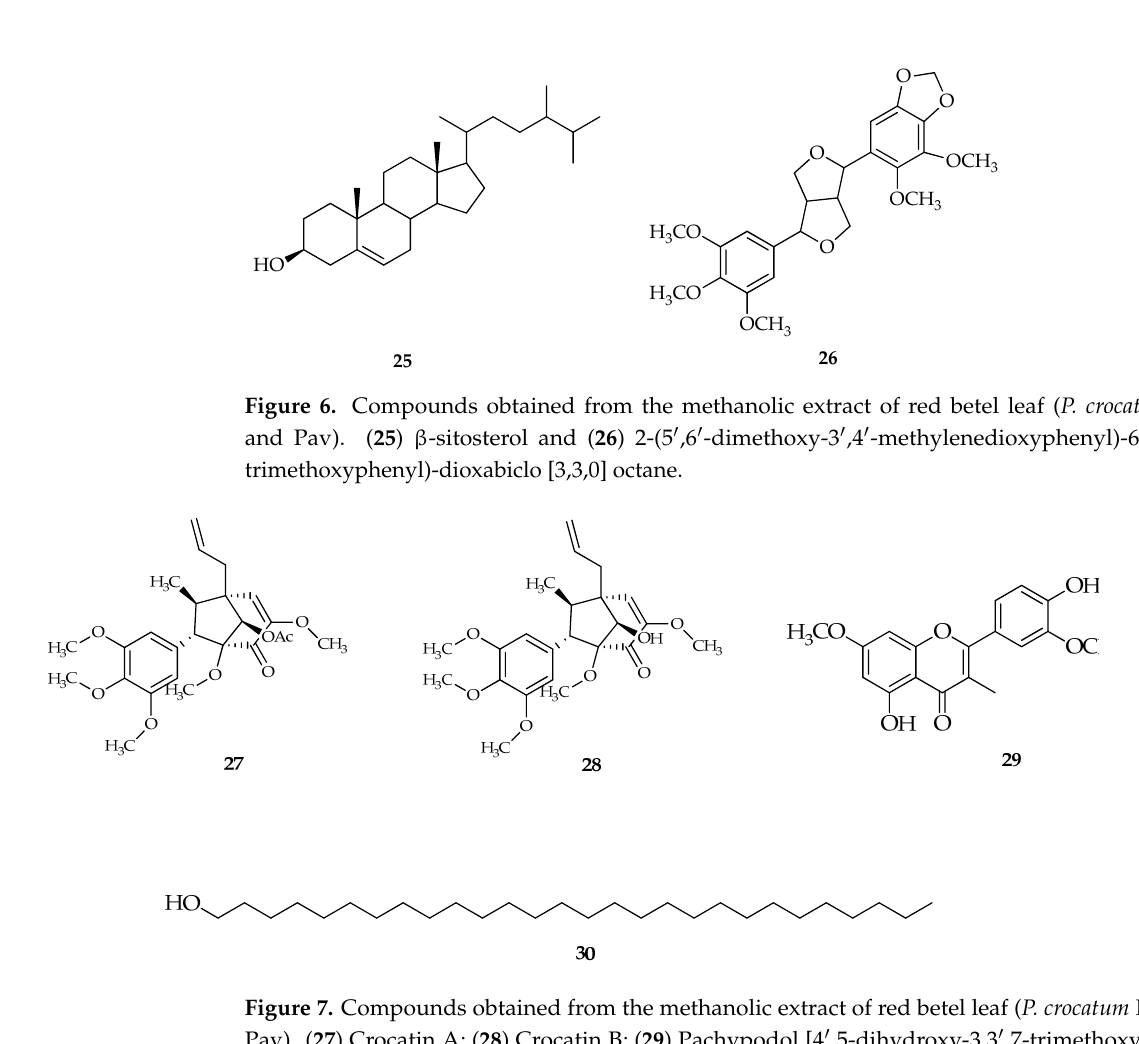
Figure 7. Compounds obtained from the methanolic extract of red betel leaf ( P. crocatum Ruiz and Pav). ( 27 ) Crocatin A; ( 28 ) Crocatin B; ( 29 ) Pachypodol [4 ′ ,5-dihydroxy-3,3 ′ ,7-trimethoxyflavone]; and ( 30 ) 1-Triacontanol.